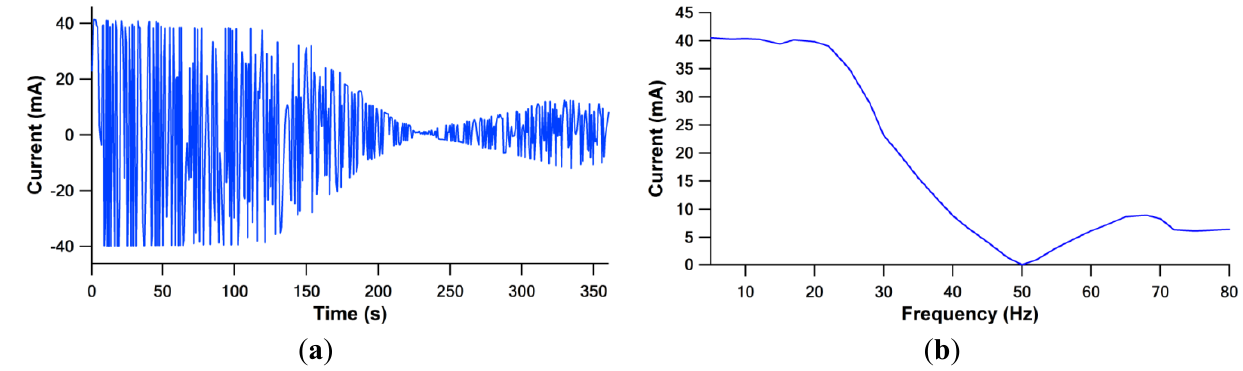
Figure 7. Actuator characterization. ( a ) Impedance profile with time domain